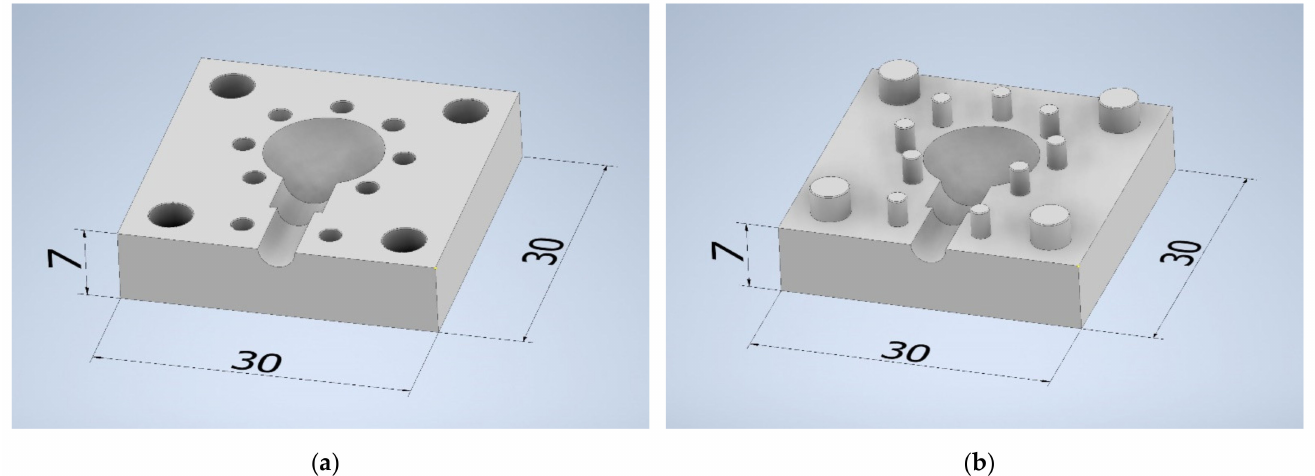
Figure 3. The 3D model of the designed injection die: ( a ) female part; ( b ) male